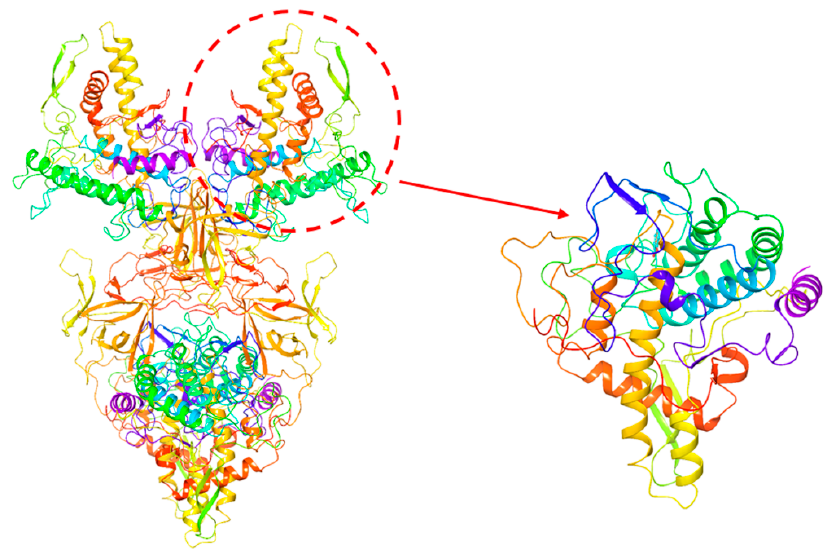
Figure 5. Mushroom Tyrosinase Crystal complex structure (PDB ID: 2Y9X).